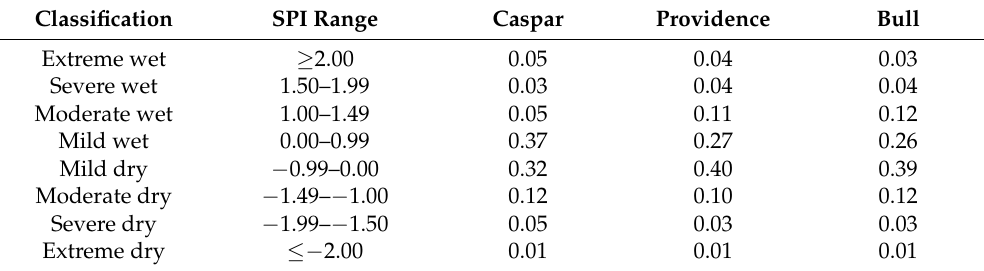
Table 2. Using the Standardized Precipitation Index (SPI) classification from McKee et al. [35], the fraction of time in the past 35 years each site experienced meteorologically wet or dry